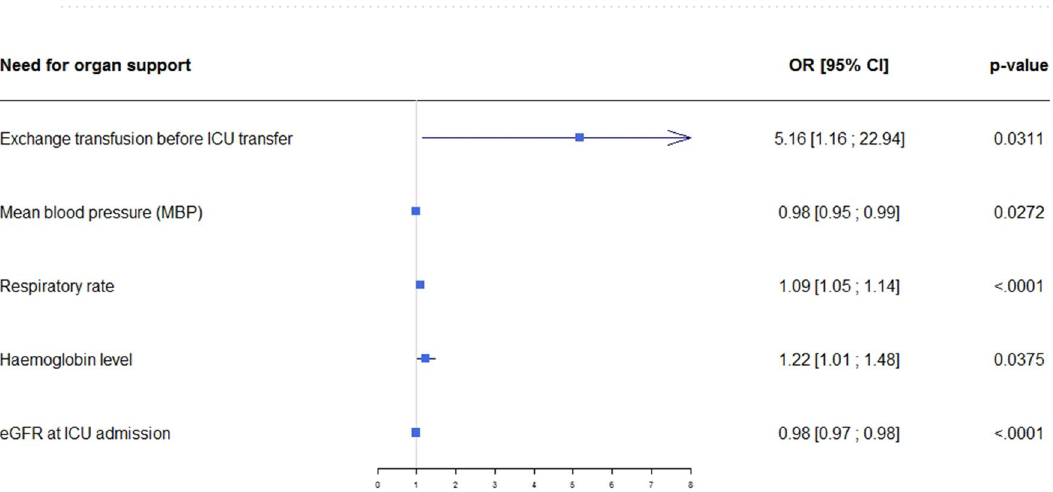
Table 3. Characteristics at ICU admission and process of care during the ICU stay. Significant values are in [bold]. The p values were obtained by univariate logistic regression and reflect associations with the occurrence of adverse outcomes. IQR interquartile range, MD missing data, AO adverse outcome defined as death or use of life-sustaining treatments, SCD sickle cell disease, MBP mean arterial blood pressure, GCS Glasgow Coma Scale, ASAT aspartate transaminase, ALAT alanine transaminase, LDH lactate dehydrogenase, PT prothrombin time, ICU intensive care unit, NSAIDs nonsteroidal anti-inflammatory drugs, RBC red blood cells, LOS length of stay, ACS acute chest syndrome, VO vaso-occlusive, VOE vaso-occlusive event, NIV non-invasive ventilation, MV endotracheal mechanical ventilation, RRT renal replacement therapy, ECMO extracorporeal membrane oxygenation, SAPS II Simplified Acute Physiology Score II. a Sepsis was suspected when mentioned in medical records and confirmed when the patient had an infection accompanied with a life-threatening organ dysfunction. b Including delayed haemolytic transfusion reaction, stroke, acute anaemia, priapism, splenic sequestration, VOE without severe pain, and VOE after surgery or childbirth. c Including cardiac arrest, pulmonary oedema, acute coronary syndrome, exacerbation of chronic respiratory failure, seizure and status epilepticus, acute kidney failure, metabolic disorders, pancreatitis, hepatitis, gastro-intestinal bleeding, gastro-intestinal occlusion, mesenteric ischaemia, haematologic disorders, anaphylaxis, and peri-partum complications.